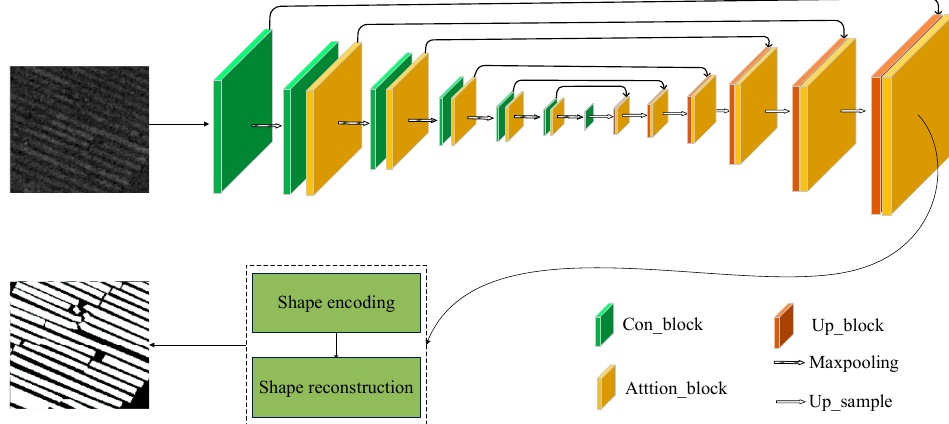
Figure 10. Schematic diagram of the model used in this study.